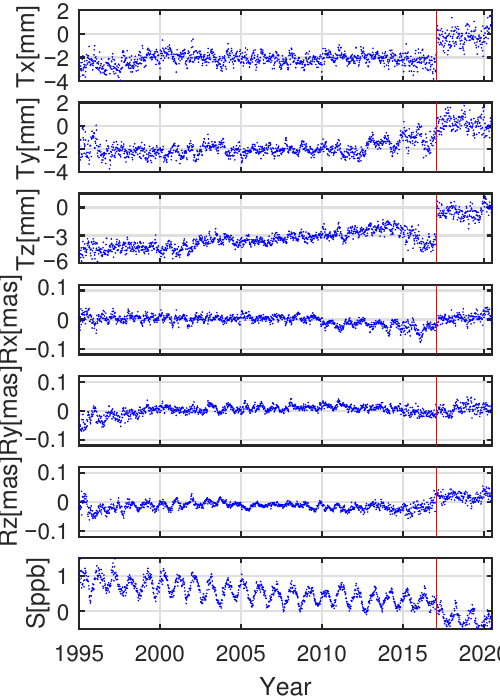
Figure 4. Time series of the Helmert transformation parameters estimated between ITRF2014 and IGS. Red vertical lines mark the discontinuities that occur in the IGS time series.